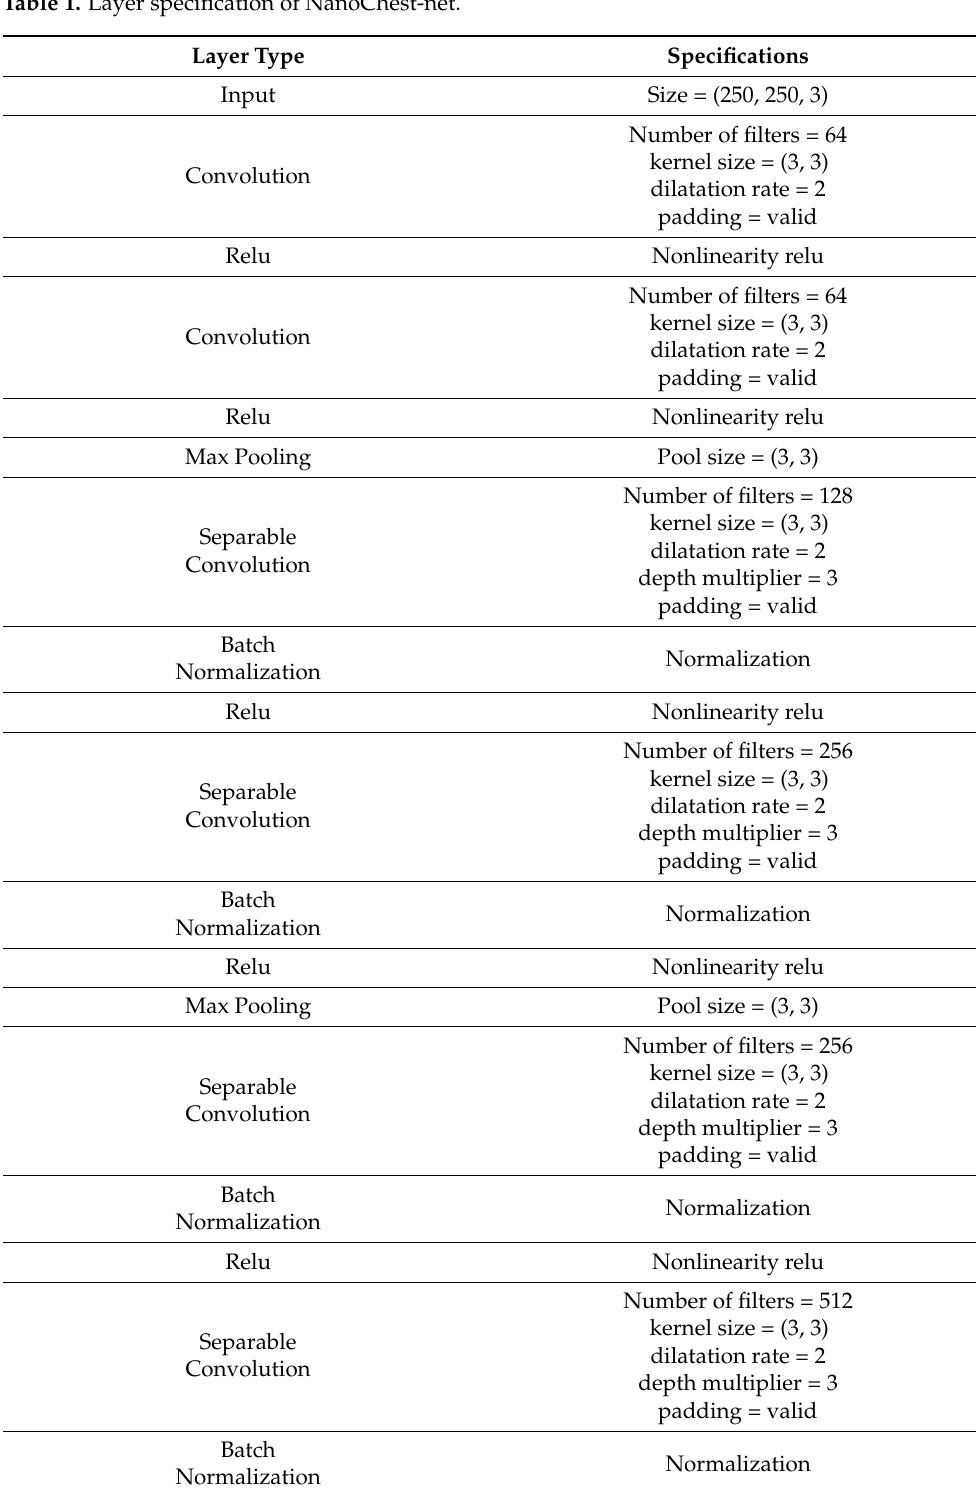
Table 1. Layer specification of